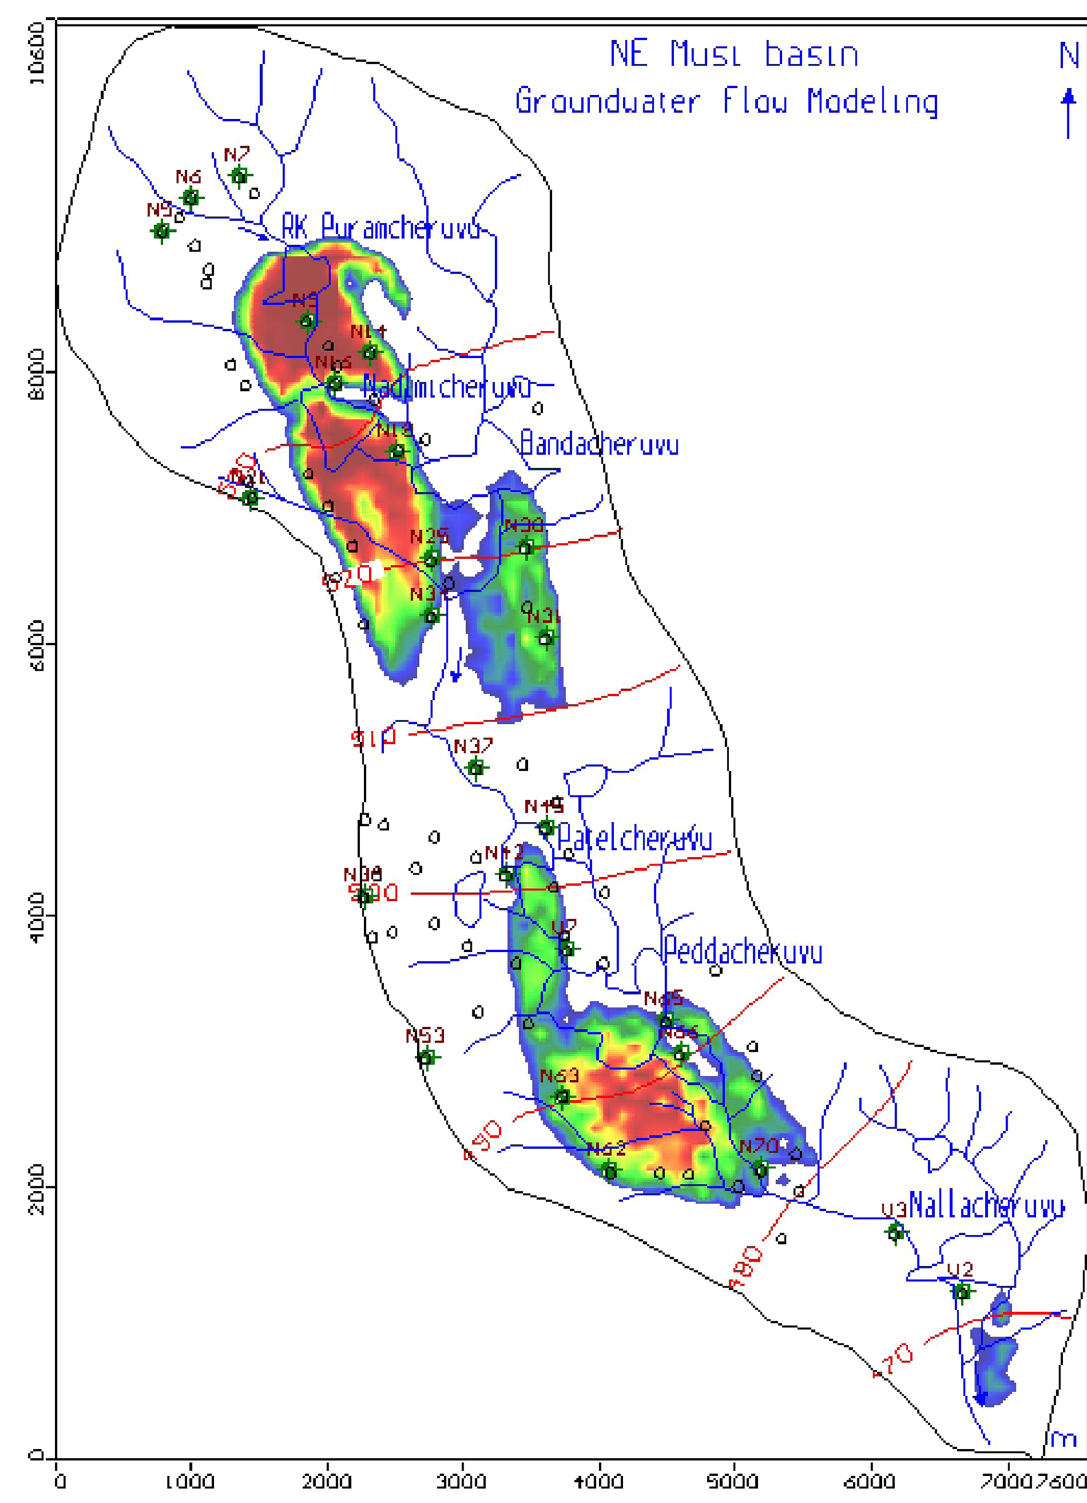
Fig. 13 Predicted TDS concentration of second layer for